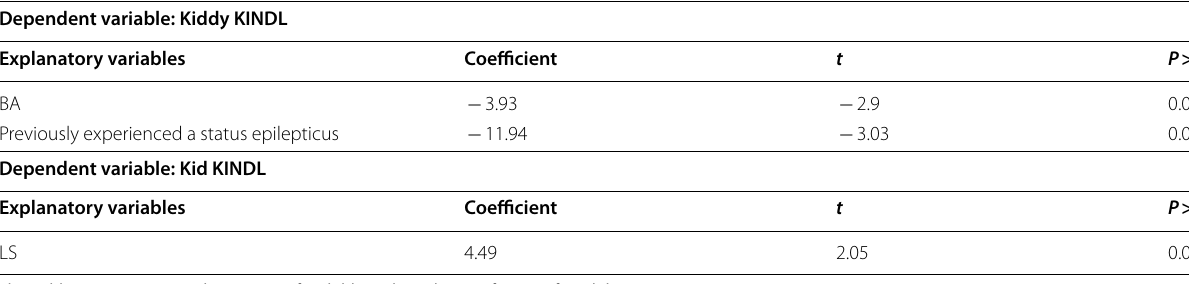
The Kiddy KINDL is an HRQol instrument for children, the Kid KINDL for 7–17 for adolescents BA behaviour and attention problems score; HRQoL health-related quality of life; LS language and speech problems